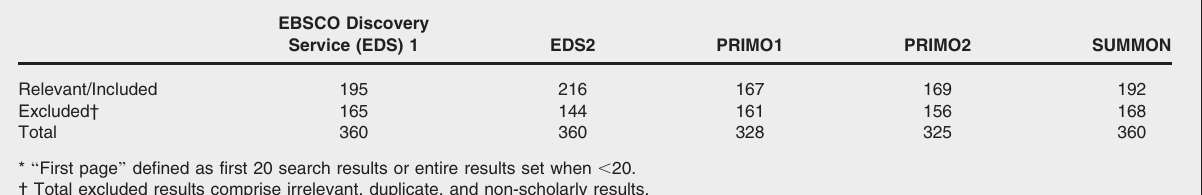
Table 1 Relevance of first page* of results from 18 search